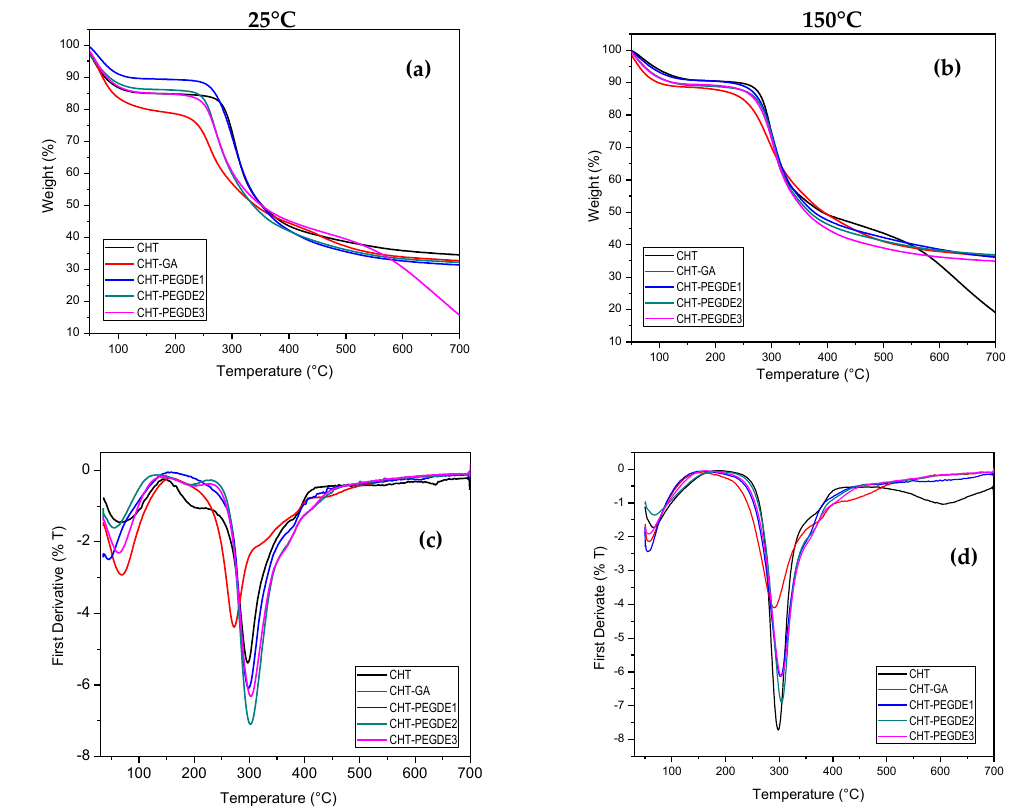
Figure 2. Thermogravimetric Analysis (TGA) ( a , b ) and DTGA ( c , d ) thermograms of Chitosan (CHT), glutaraldehyde crosslinked chitosan (CHT-GA) and polyethylene glycol diglycidyl ether (PEGDE) crosslinked chitosan.